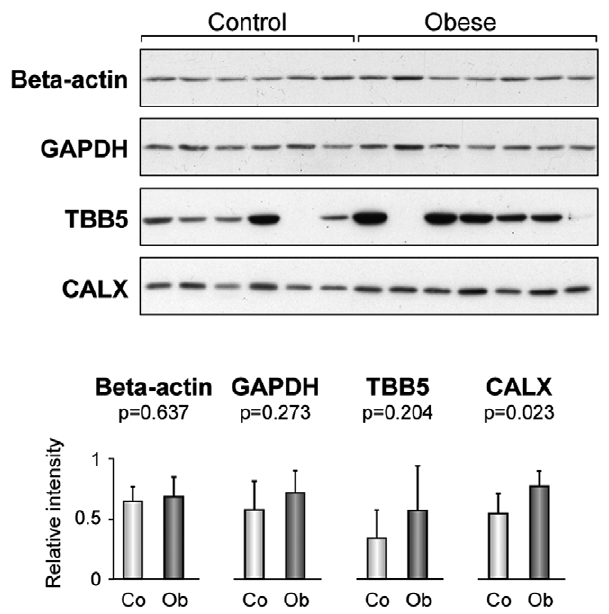
Figure 3. Protein expression levels in omental adipose tissue from non-obese and obese subjects. Representative Western Blot analysis of Beta-actin, GAPDH, TBB5 and CALX expression in omental fat samples from non-obese (control) and obese subjects. Relative intensity values from band densitometry are expressed as mean 6 SD.